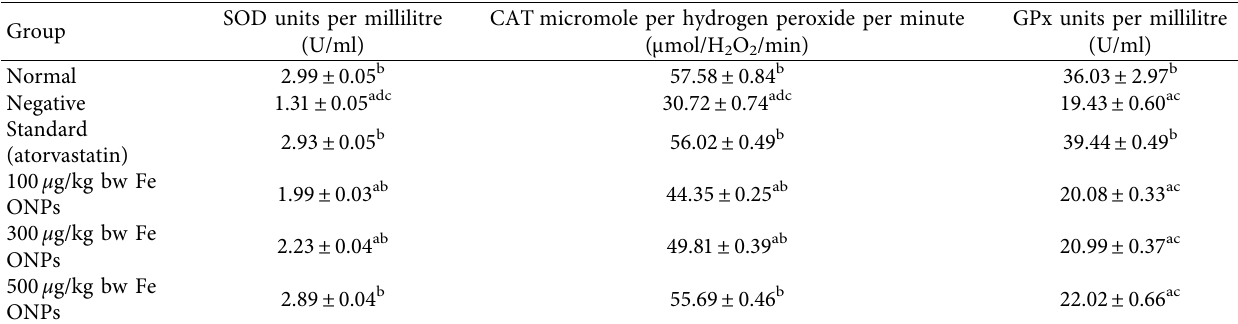
Table 4: Effect of iron oxide nanoparticles on serum antioxidant markers.